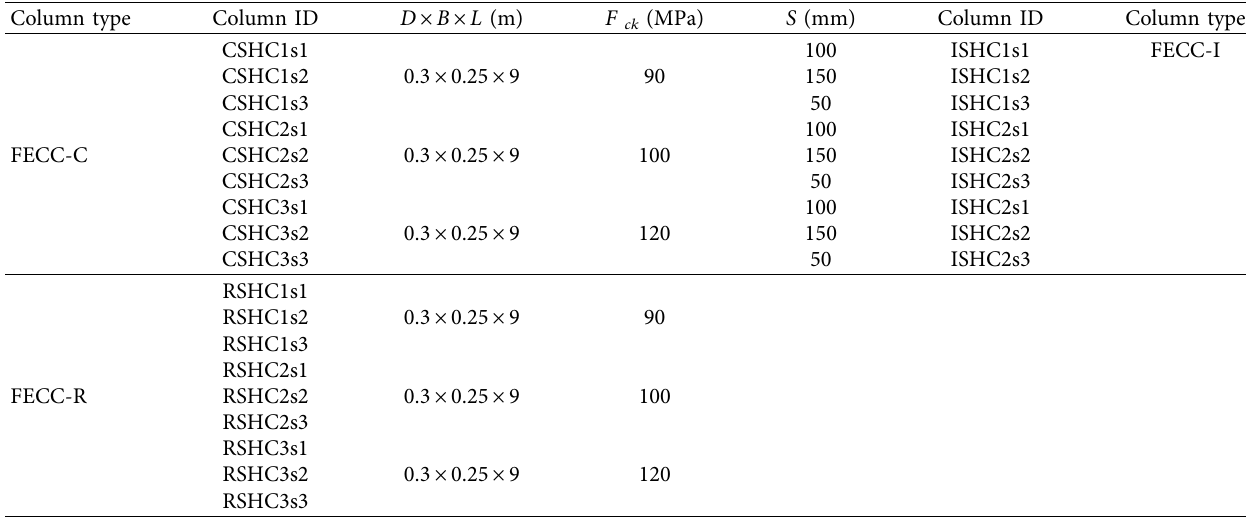
Table 7: Specimens for efects of tie bar spacing (s).